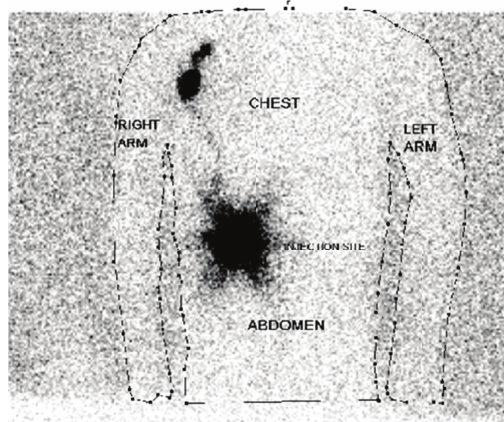
Figure 1: Lymphoscintigraphy demonstrating uptake in the right axilla.